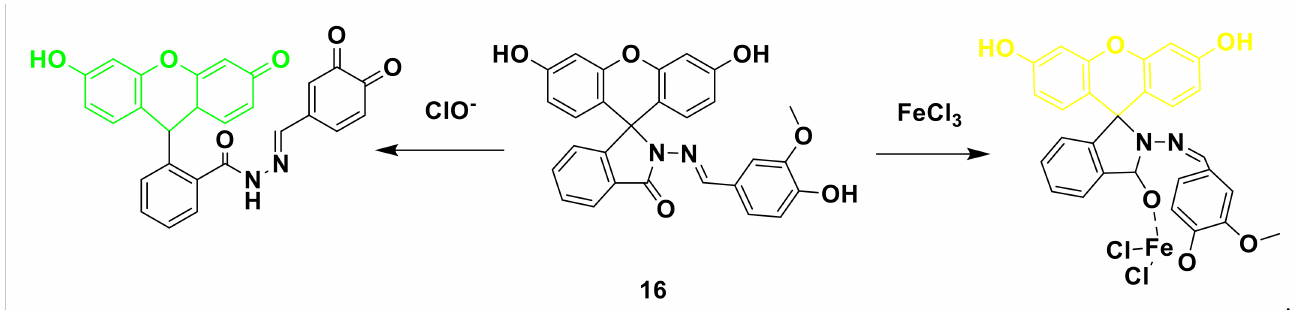
Figure 18. The reaction of probe 16 and ClO −